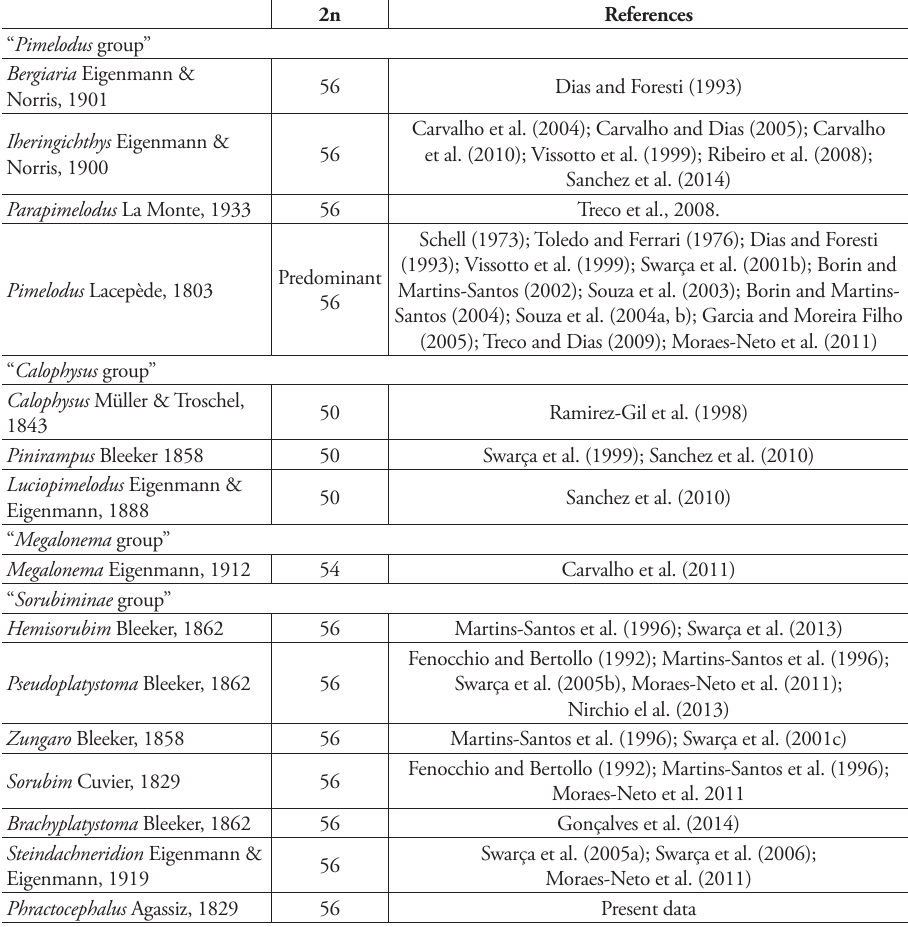
Table 1. Cytogenetic data on the family Pimelodidae. 2n = diploid number. Only published data were used.